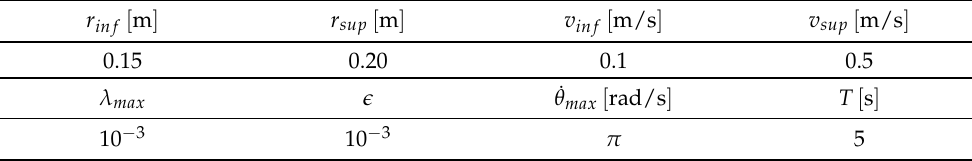
Table 1. Parameter values used for both simulation and real